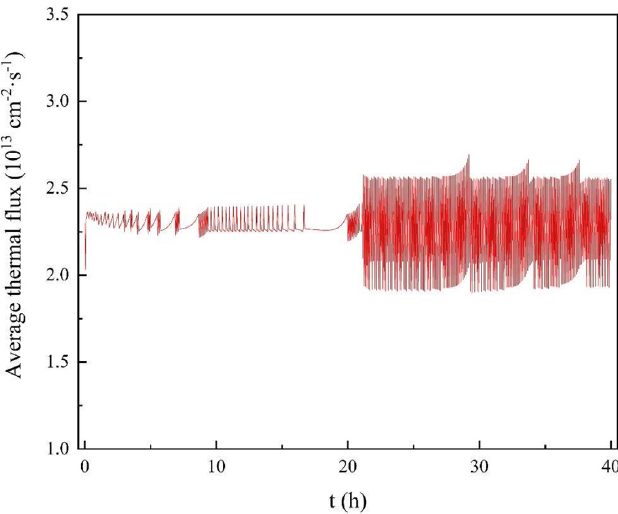
Fig. 13. Evolution of the average thermal fl ux ( “ symmetric ” control).